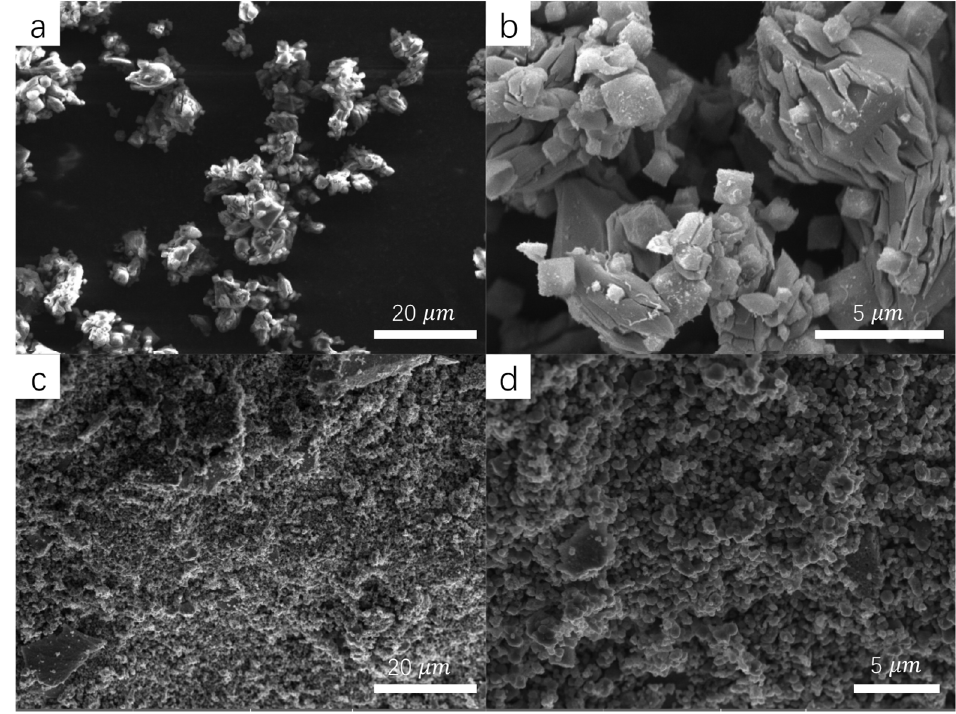
Figure 1. SEM images of the MOF-235 ( a , b ) and TiO 2 -P25 mesoporous composite ( c , d ).